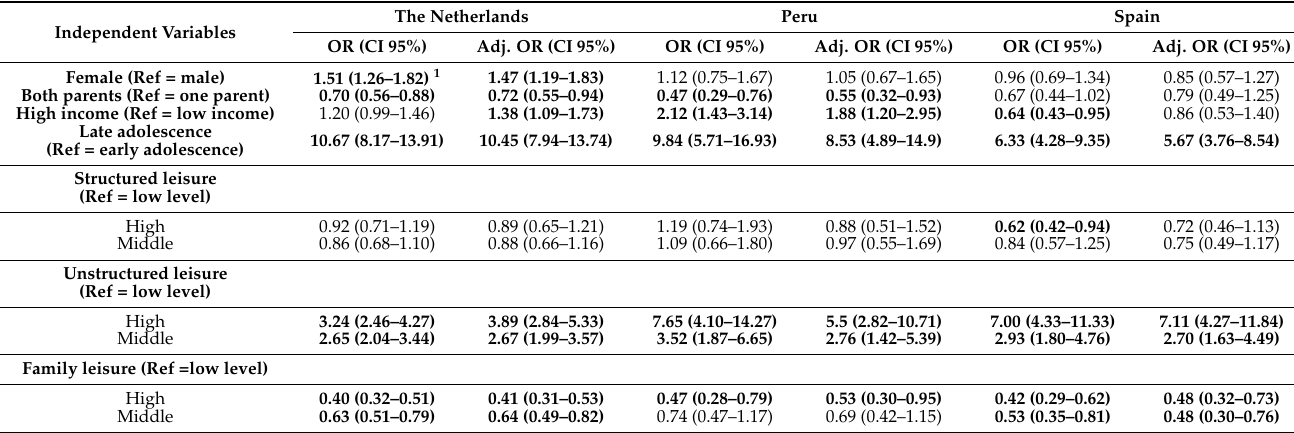
Table 5. Odds ratio and 95% confidence limits for yearly binge drinking (YBD) in each country, raw and adjusted by confounders.